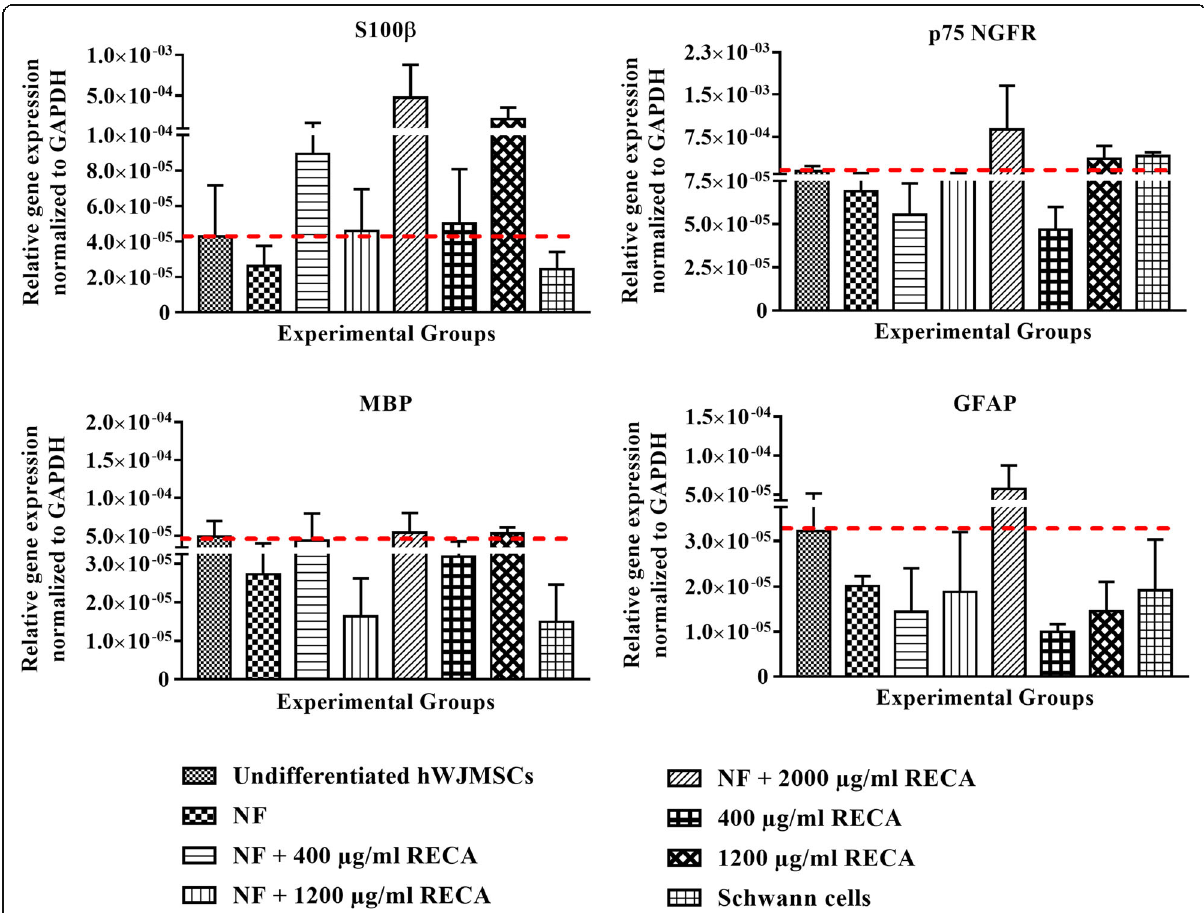
Fig. 8 Gene expression analysis of S100 β , p75 NGFR, MBP and GFAP in differentiated hWJMSCs from different induction groups. Data are presented as relative gene expression normalized to the housekeeping gene, GAPDH. The gene expression level of all the neural gene markers was not significantly different among experimental groups, p < 0.05 ( n = 3). GAPDH; glyceraldehyde 3-phosphate